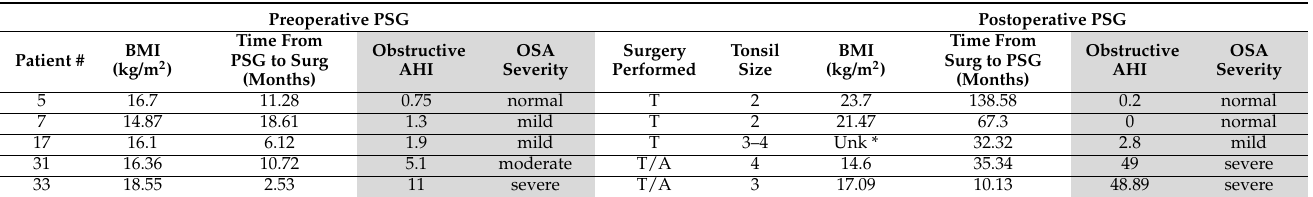
Table 3. Preoperative and postoperative polysomnography. Polysomnography results are highlighted in gray